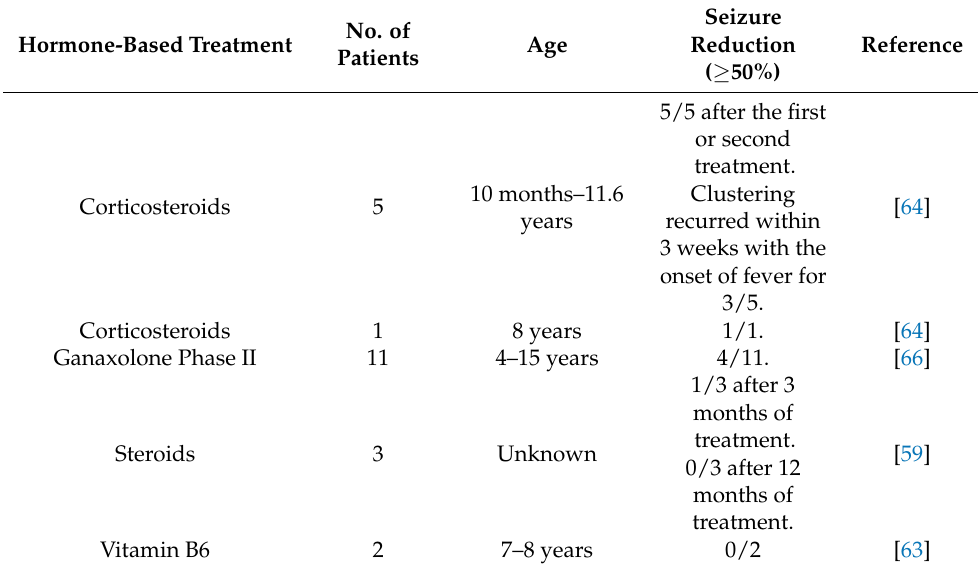
Table 1. Hormone-based AEDs for treating CE. Investigations into the efficacy of steroids for CE treatment have given mixed results. No. Hormone-Based Treatment